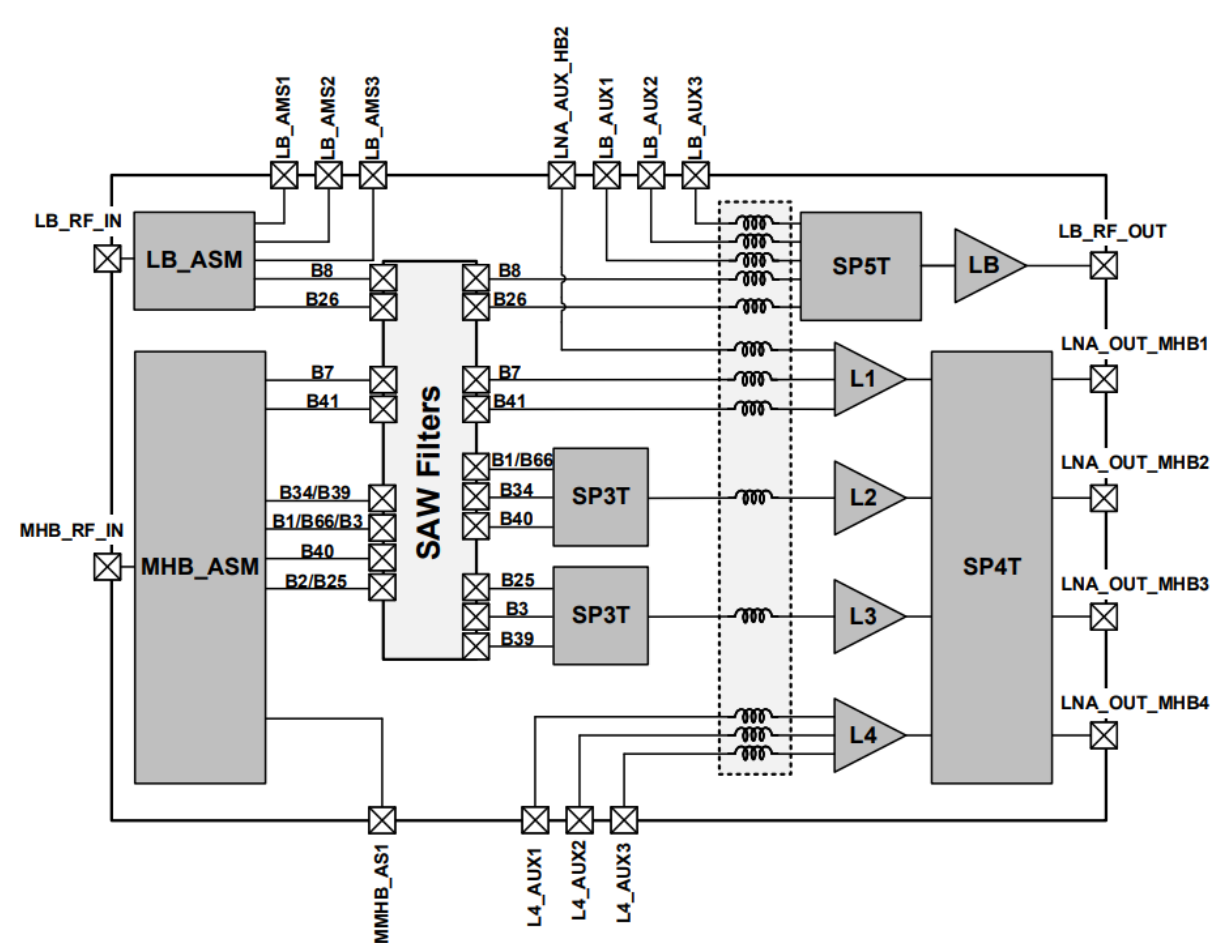
Figure 1. Block diagram of the diversity RF front-end for 2G/3G/4G/5G multi-mode cellular